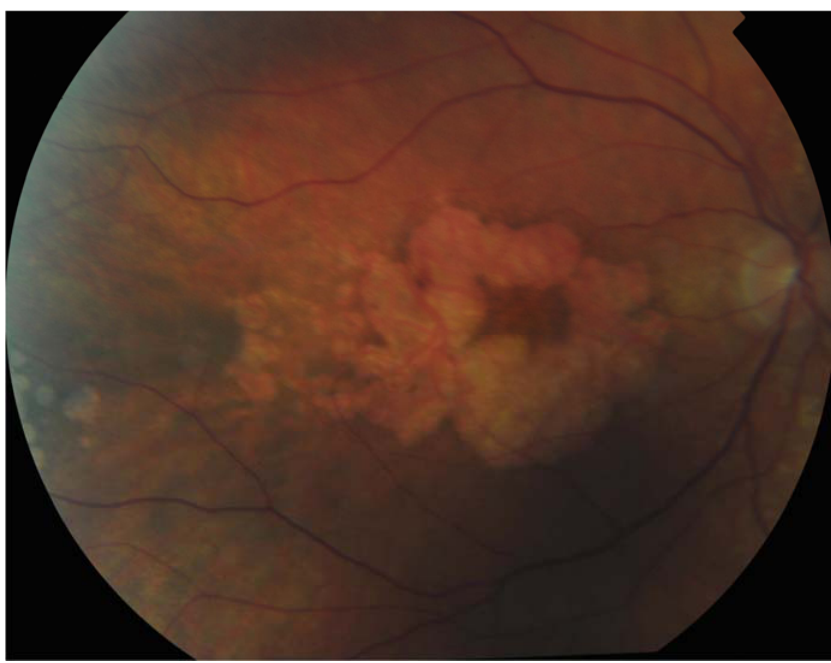
Figure 2. Patient with Sorbsy’s fundus dystrophy showing geographic atrophy with foveal